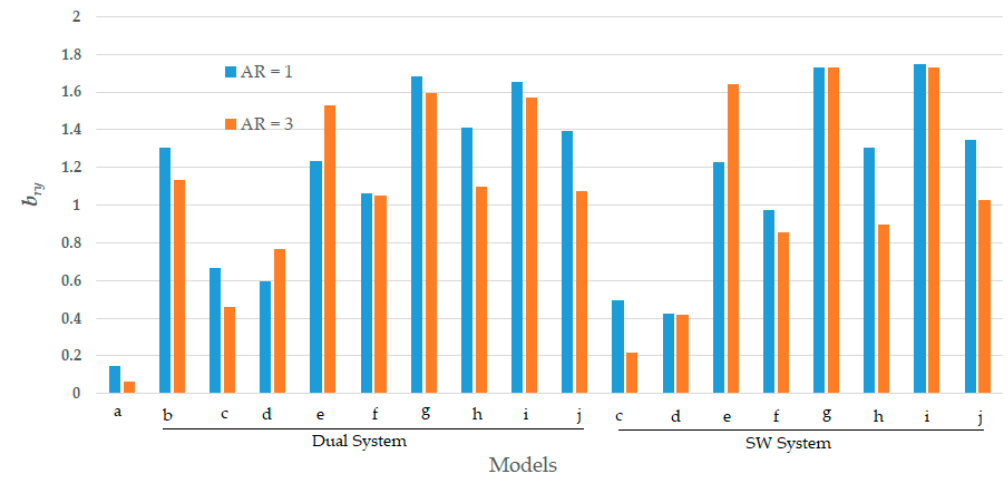
Figure 7. Comparison of the results of the elastic radius ratio ‘ b ry ’ for the buildings with an aspect ratio (AR) of 1 and 3, and a building height of 13.1 m.